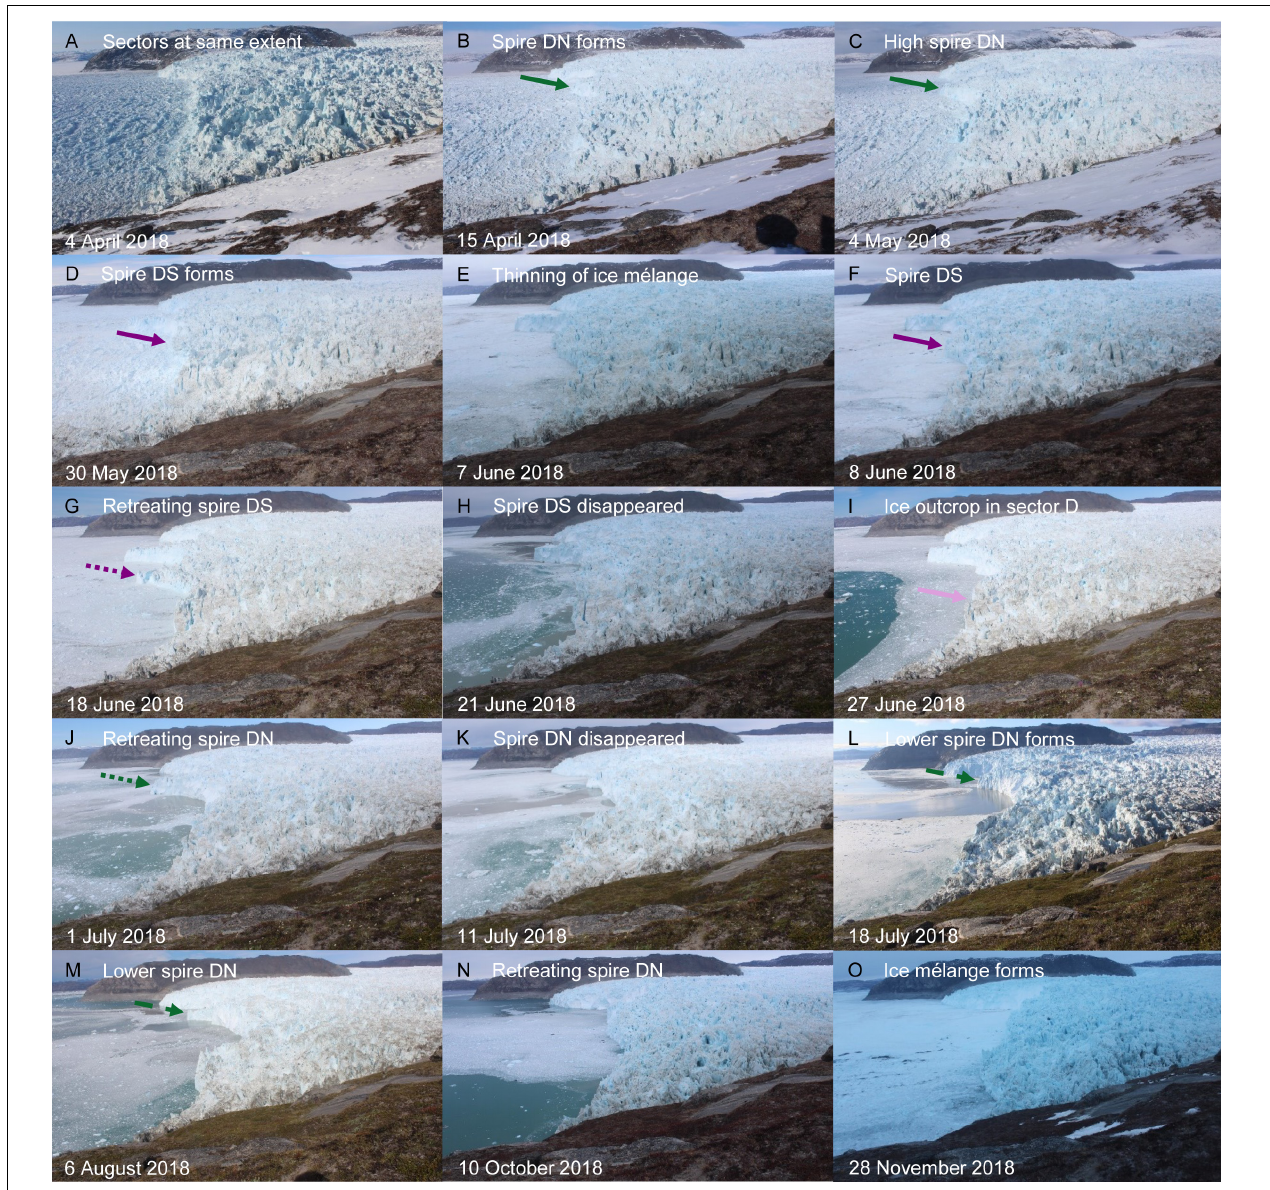
FIGURE 8 | Calving front evolution during the year 2018 illustrated with selected hTLC images (A–O) . The different colored arrows correspond to the states shown in Figure 9